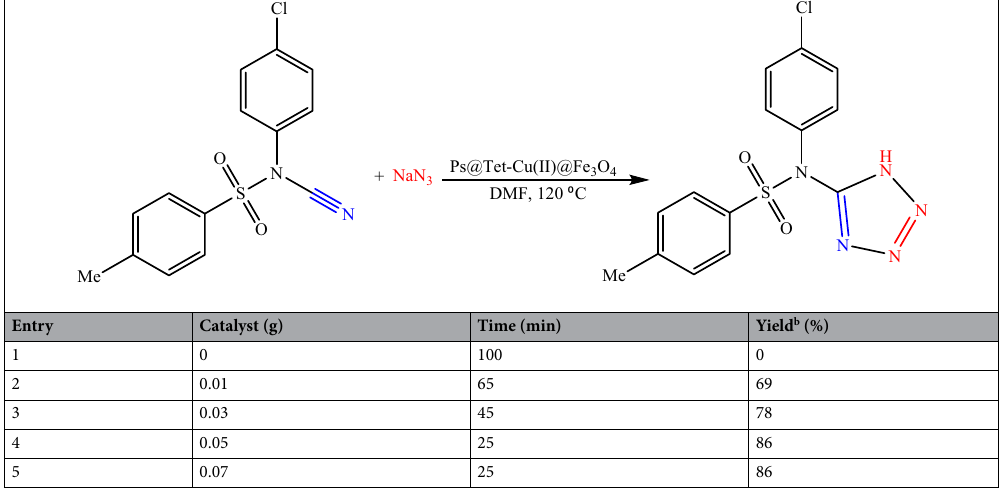
Table 1. Optimization of reaction conditions a . a Reaction conditions: N -(4-chlorophenyl)- N